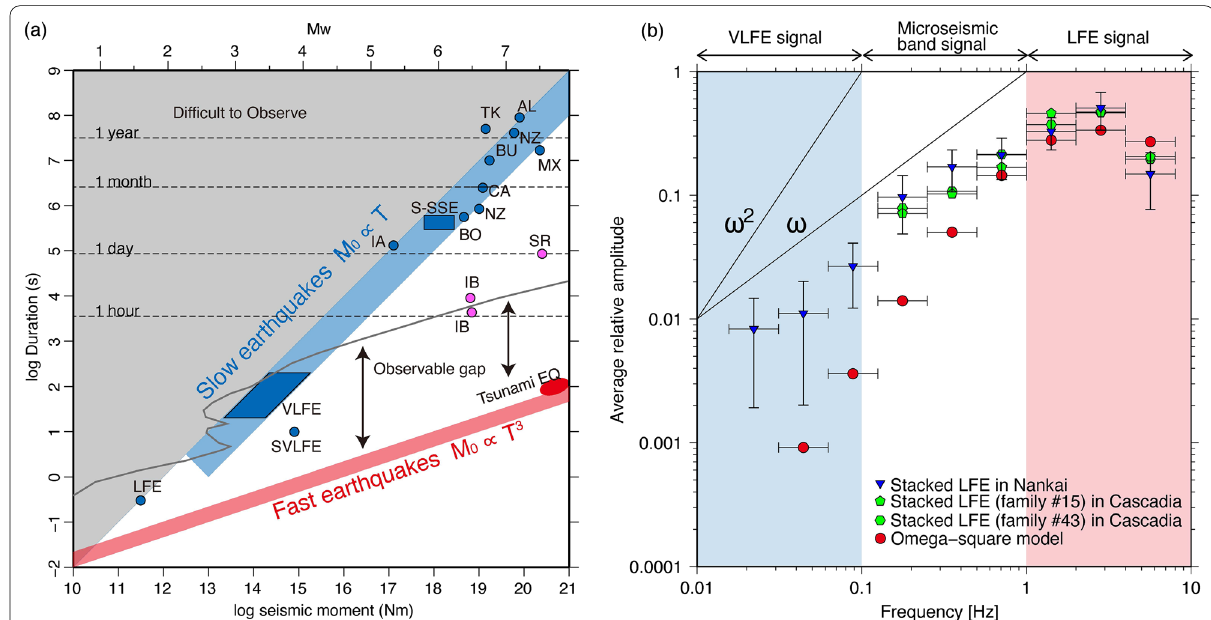
Fig. 3 Slow earthquakes as broadband fault slip phenomena. a Moment–duration scaling relations of slow and fast earthquakes. Blue and magenta symbols represent slow earthquakes. LFE, VLFE, SVLFE, and S-SSE indicate LFEs (Ide et al. 2007b), deep VLFEs (Ito et al. 2007; Ide et al. 2008), shallow VLFEs (Ito and Obara 2006), and short-term SSEs (Hirose and Obara 2005) in the Nankai Trough, respectively. Other symbols are as follows: IA, a small short-term SSE near the Kii Peninsula, southwest Japan (Itaba and Ando 2011); BO, a short-term SSE near the Boso Peninsula, eastern Japan (Sagiya 2004); NZ, short- and long-term SSEs in Hikurangi, New Zealand (Wallace et al. 2012); CA, short-term SSEs in Cascadia (Dragert et al. 2004); BU, a long-term SSE in the Bungo Channel, southwest Japan (Hirose and Obara 2005); MX, a long-term SSE in Guerrero, Mexico (Kostoglodov et al. 2003; Yoshioka et al. 2004); TK, a long-term SSE in the Tokai region, central Japan (Miyazaki et al. 2006); AL, a long-term SSE in Alaska (Ohta et al. 2006); IB, aseismic transients in the Izu–Bonin subduction zone (Fukao et al. 2021); and SR, the 1992 Sanriku-Oki ultraslow earthquake in the northern Japan Trench (Kawasaki et al. 1995). The thick red line represents the scaling relationship of fast earthquakes. The red ellipse indicates tsunami earthquakes (Kanamori 1972; Ide et al. 1992). The gray curve represents the approximate observational limit of seismological instruments suggested by the US Geological Survey low-noise model (Peterson 1993). This panel is adapted from Ide (2014). b Average maximum amplitude of stacked LFE waveforms for each frequency band. The maximum amplitudes of seismic signals in each frequency band are averaged for each component of each station. Blue inverted triangles represent stacked LFE waveforms in the Nankai Trough (Masuda et al. 2020). Green symbols indicate stacked LFE waveforms in the Cascadia subduction zone (Bostock et al. 2015; Ide 2019b). For comparison, the average maximum amplitude of synthetic waveforms that obey the omega-square model (Aki 1967) with a 2 Hz corner frequency is shown. This panel is adapted from Masuda et al.